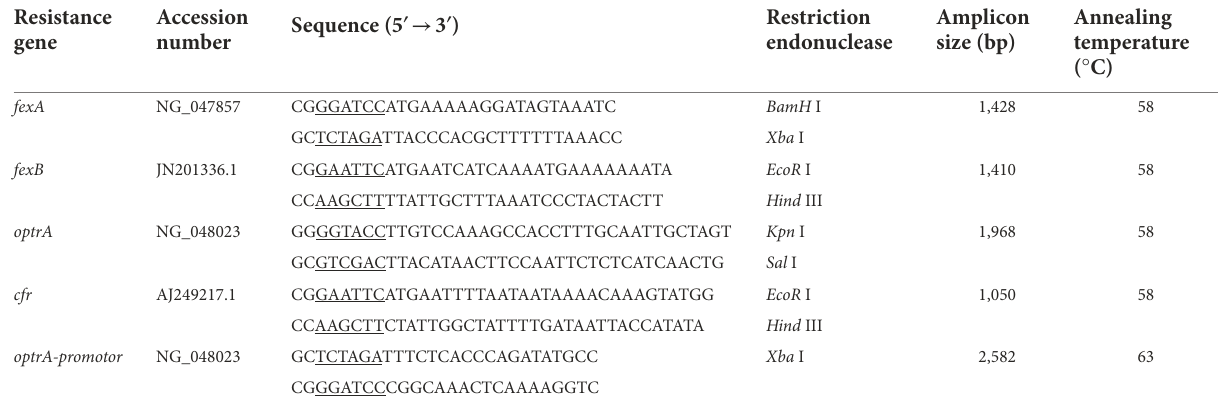
TABLE 1 Primer sequences and PCR product sizes of the florfenicol and oxazolidinones resistance genes. Resistance